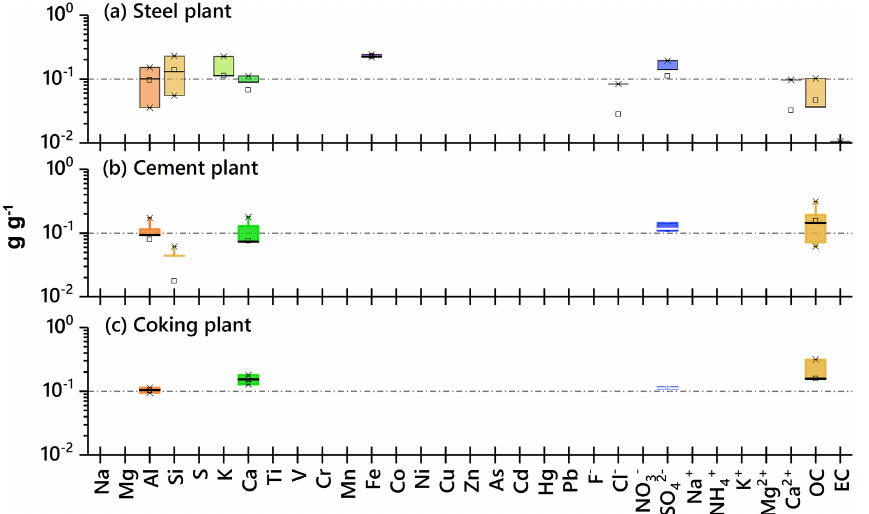
Figure 8. Characteristics of chemical profiles for PM from industrial emissions. Data from the Nankai University source library, Zhao et al. (2015a), Qi et al. (2015), Ma et al. (2015) and Yan et al. (2016) were collated.